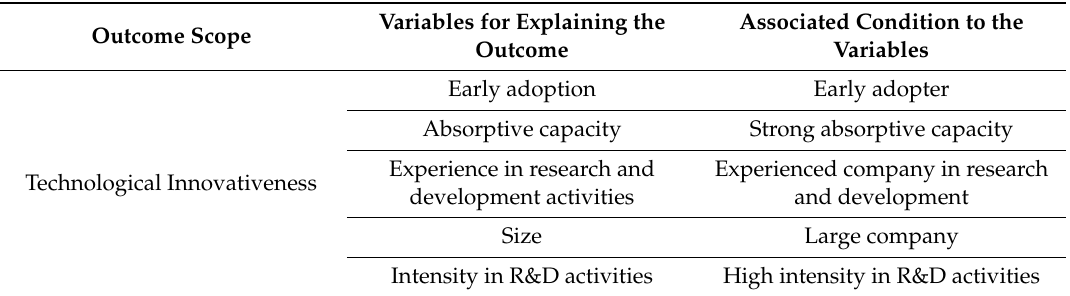
Table 1. Outcome scope, variables, and associated conditions.